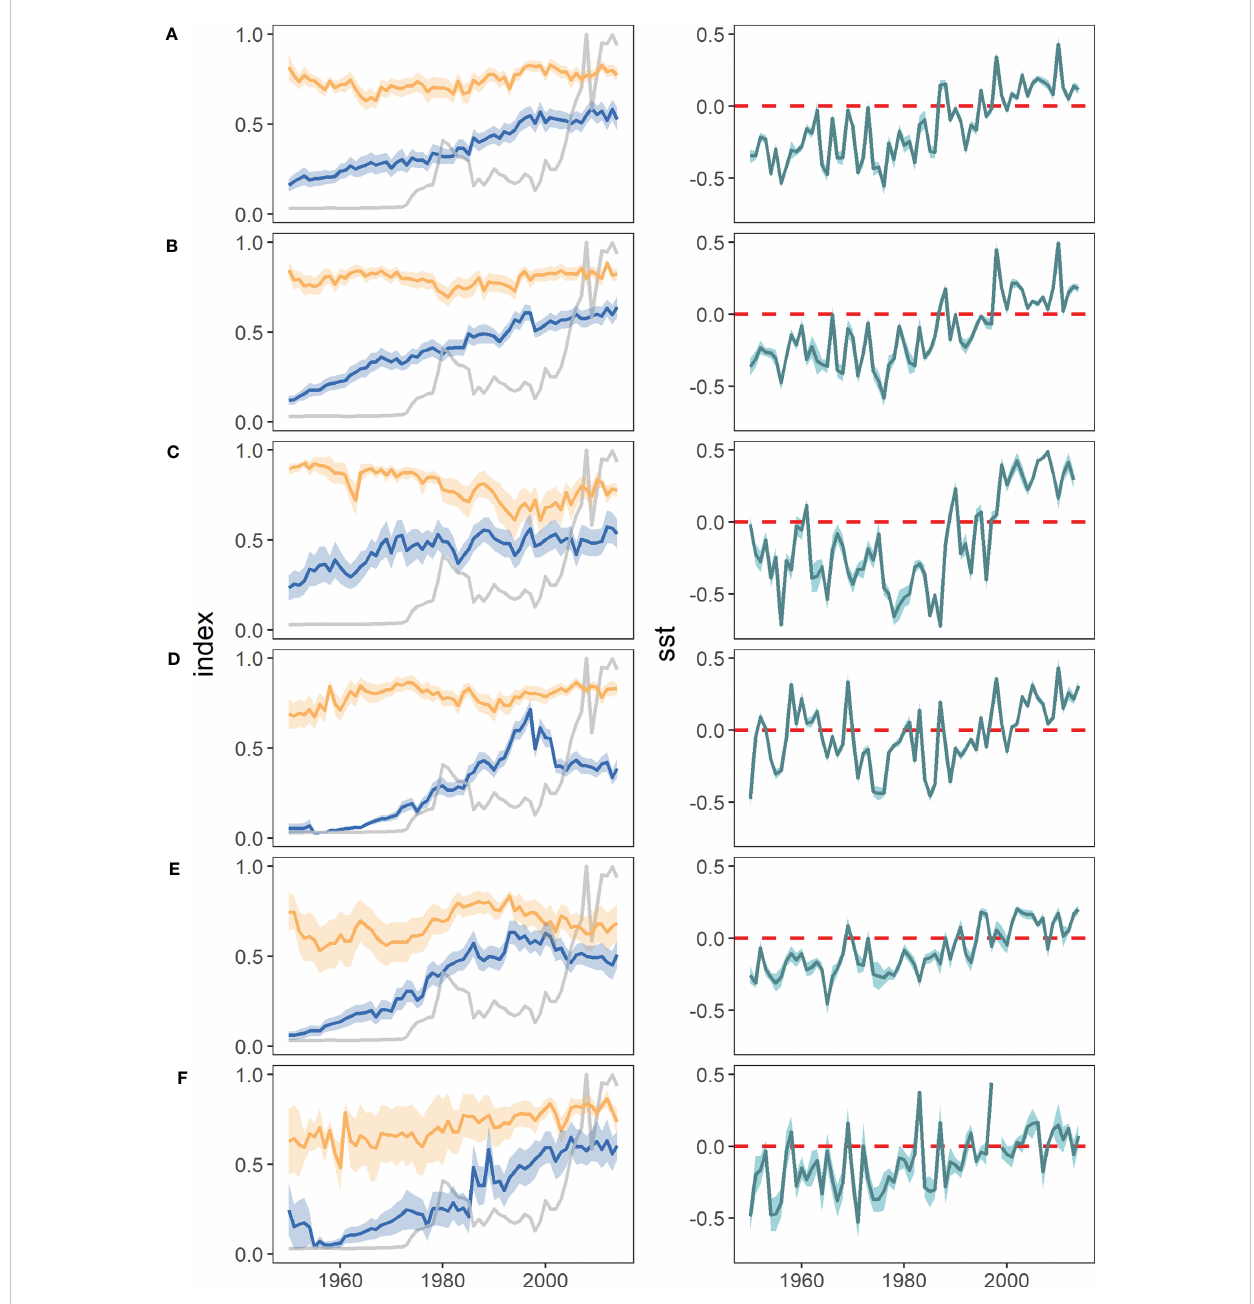
FIGURE 3 Time series for the predictor variables over the study period by region for (A) Africa, (B) Asia, (C) Europe, (D) North America, (E) Oceania, and (F) South America. Envelopes around the lines are ±1 standard errors for mean technical ef fi ciency (orange lines), the scaled composite nominal price index by country (blue lines), and the mean SST (green lines). The solid grey lines correspond to the scaled nominal fuel price index. Nominal fuel price index scaled, (solid grey line). Mean SST (green line with standard